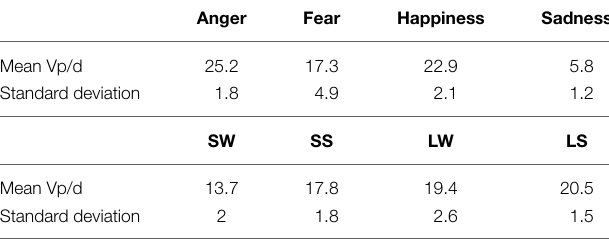
( Table 3 ) reveal more detailed patterns: anger and happiness have significantly higher dynamics than fear and sadness. The differences between anger and happiness are